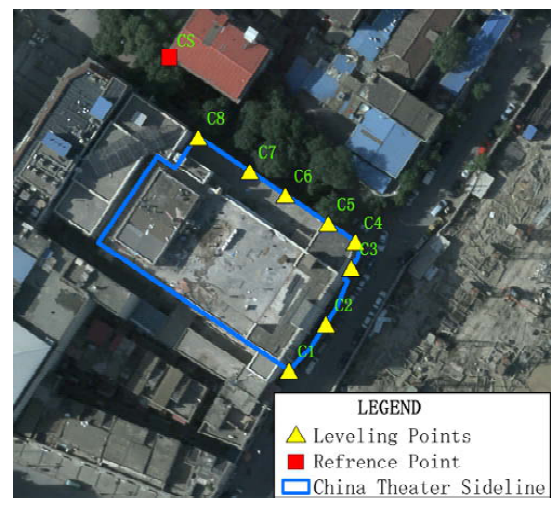
Figure 6. Locations of Leveling points and reference points for the displacement monitoring of the China Theater using leveling technique, with aerial ortho ‐ photo of 0.2 m as background. Table 3. Displacement results of two building from leveling (mm).